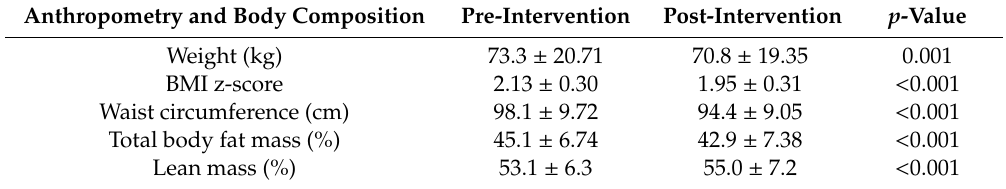
Table 2. Change in anthropometric variables in obese asthmatic children following a 10-week dietary intervention.